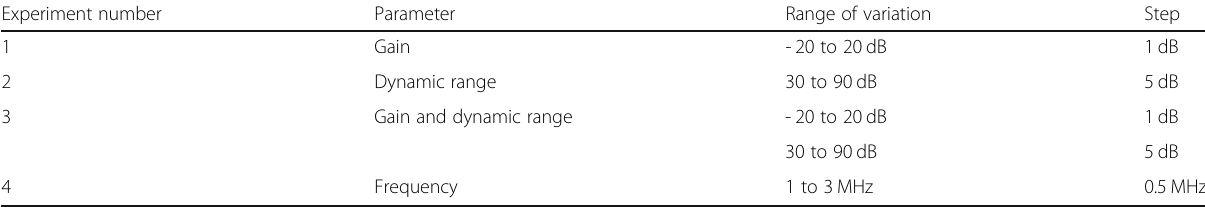
Table 1 Input parameters and corresponding variations introduced to the system Experiment